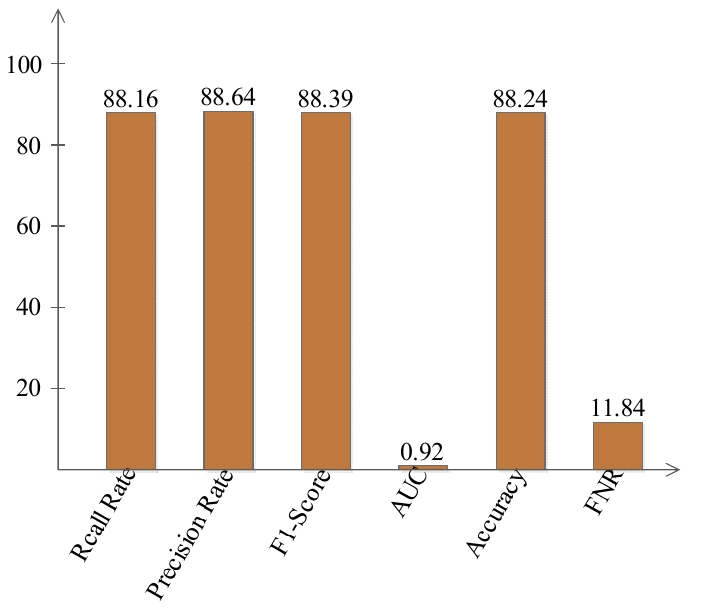
Figure 7. The performance measures computed for the best accuracy value.